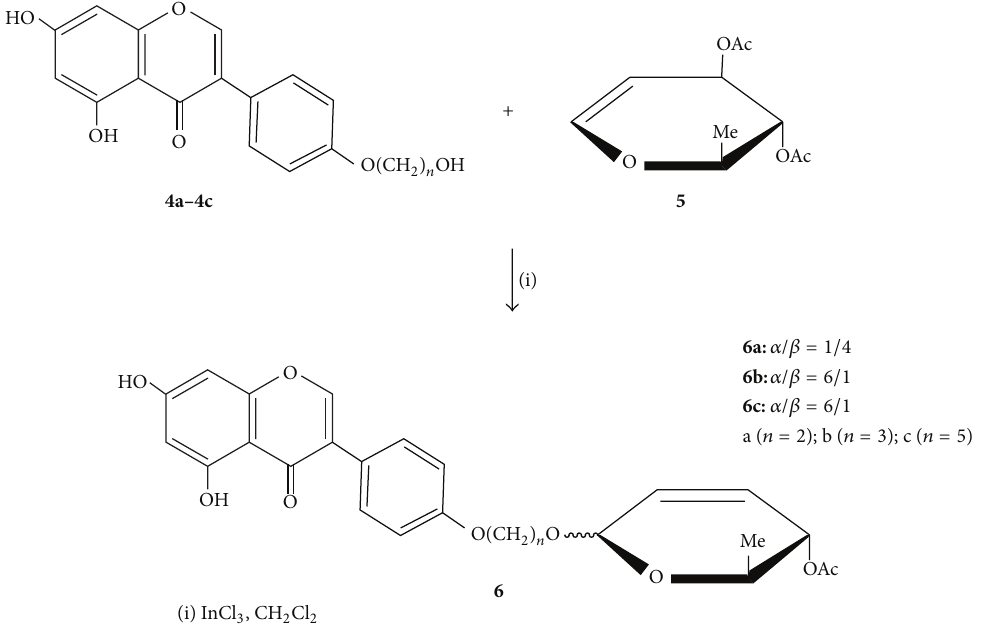
Figure 1: Synthesis of 4 󸀠 -(hydroxyalkyl) genistein.